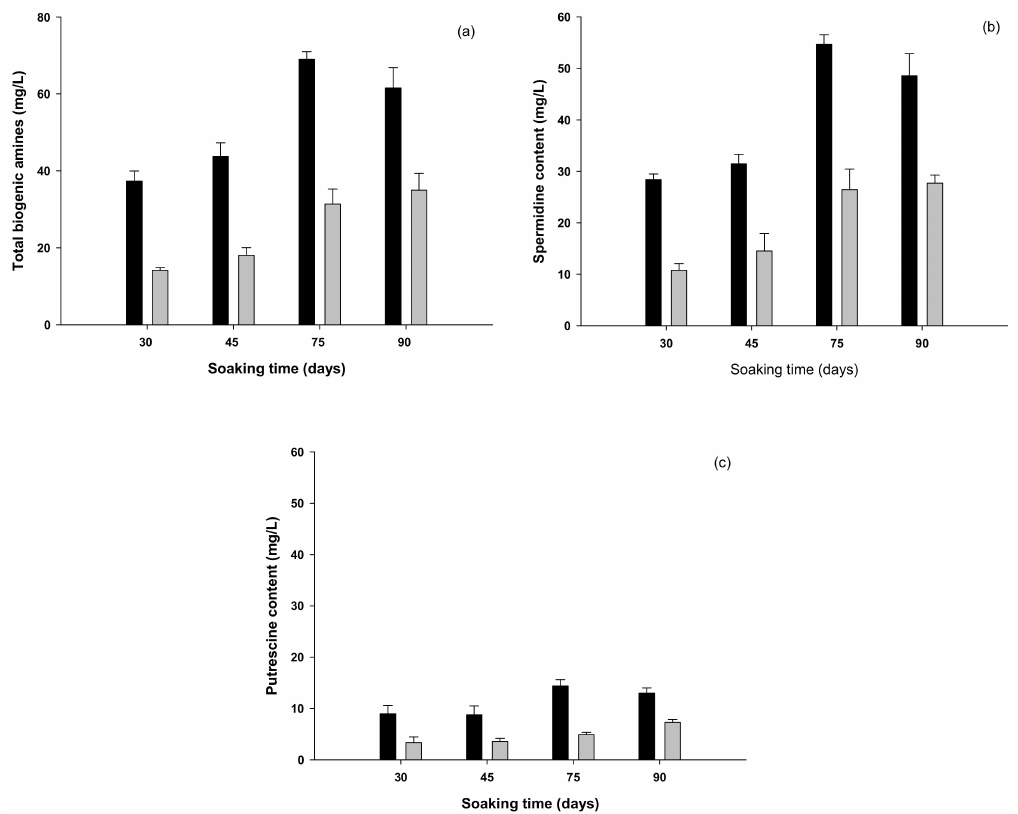
Figure 2. The content (mg / L) of total biogenic amines ( a ), spermidine ( b ), and putrescine ( c ) during soaking at 25 °C ( ) and 15 °C ( ).